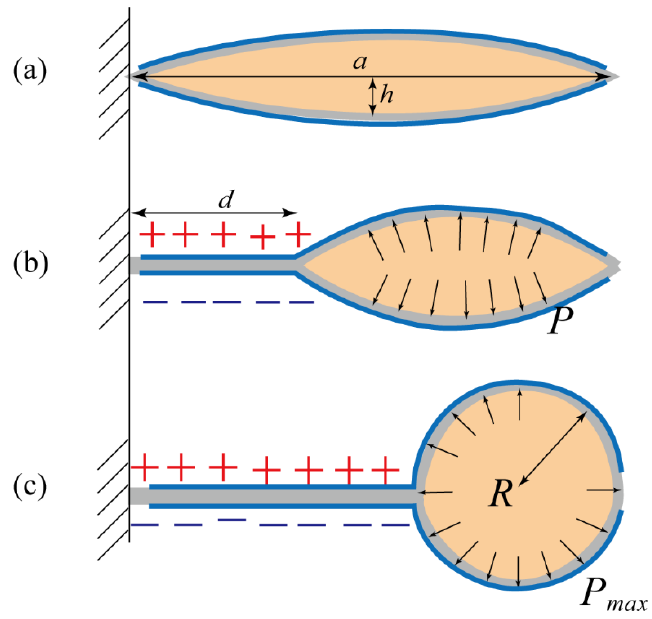
Figure 3. The cross-section view of the pouch with the original shape shown in Figure 2a. We assumed that the liquid inside the pouch remains a constant volume, and the outline of the pouch maintains a portion of a circle, where a is the lateral distance and h represents the half-thickness of the pouch. r is the radius to the outline of inactive pouch, and the electrode is attached on the whole length of the pouch.